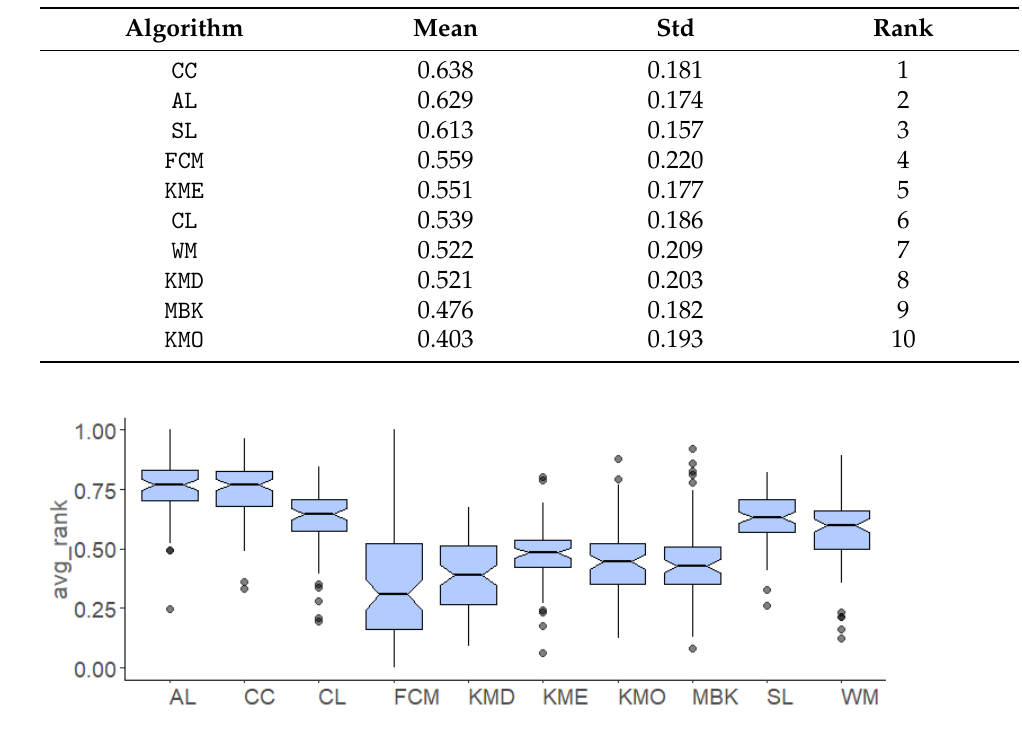
Figure 3. Average performance ranking of the algorithms for ellipsoidal